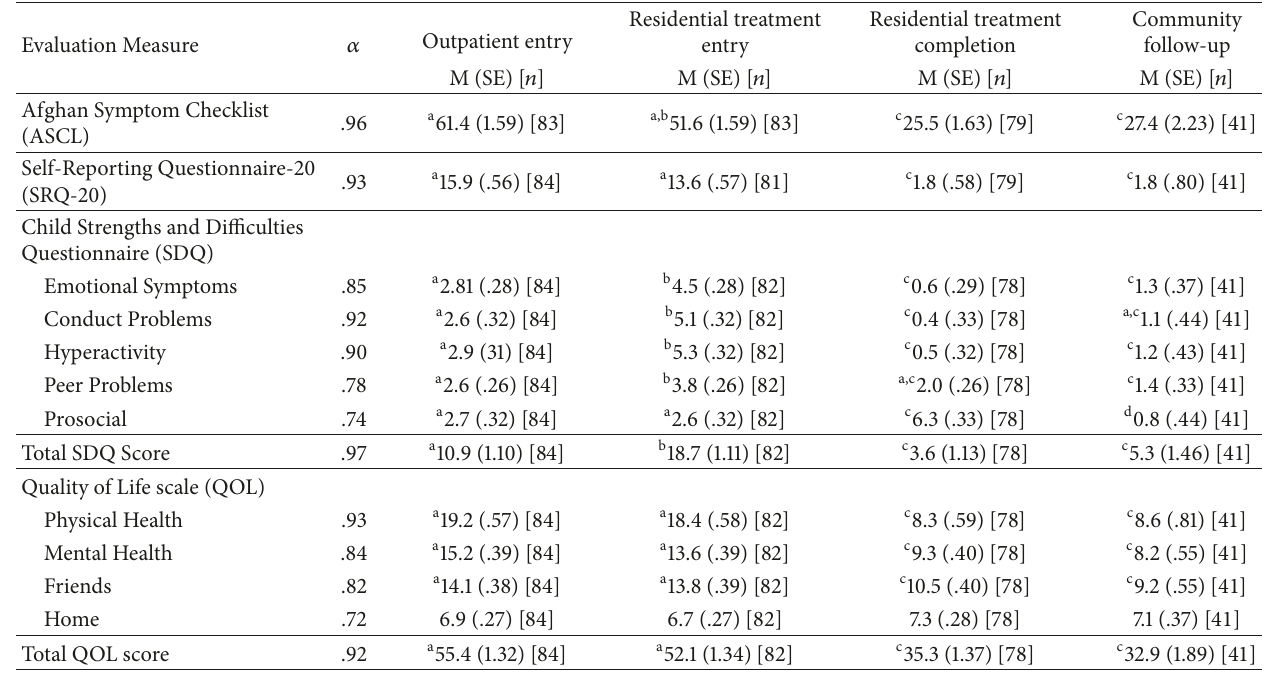
Table 3: Internal consistency reliability at residential treatment entry, estimated marginal means (M), Standard Errors (SE), and sample sizes [𝑛] at outpatient assessment, residential treatment entry, residential treatment completion, and community follow-up for the older male sample ( 𝑁 = 84